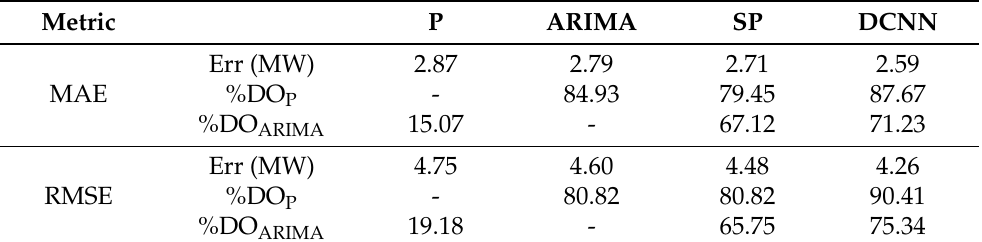
Table 2. Key forecast errors and daily outperformance percentages over P (%DO P ) and ARIMA (%DO ARIMA